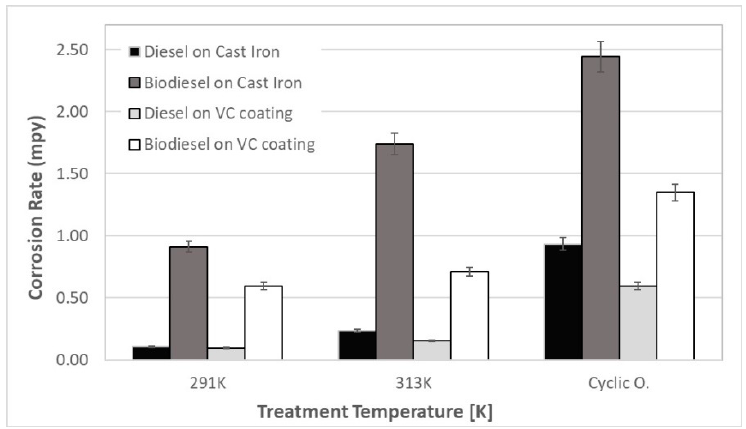
Figure 2. Corrosion rates of the gray cast iron and VC coating in diesel and biodiesel.